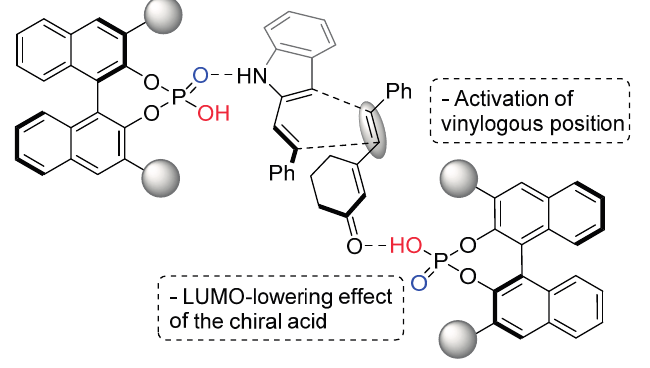
Figure 7. LUMO-lowering activation of the more distant double bond of α , β , γ , δ -unsaturated cyclic